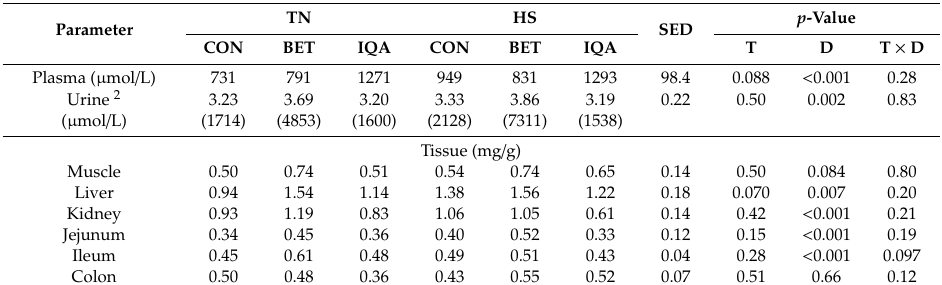
Table 6. E ff ect of thermoneutral (TN) and heat stress (HS) conditions and control (CON), betaine (BET) or isoquinoline alkaloids (IQA) on betaine distribution in growing pigs 1